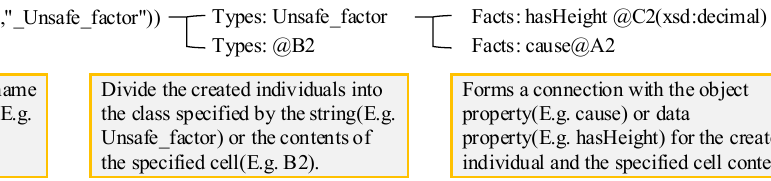
Figure 8. Transformation rule language statements of spreadsheet data to ontology.